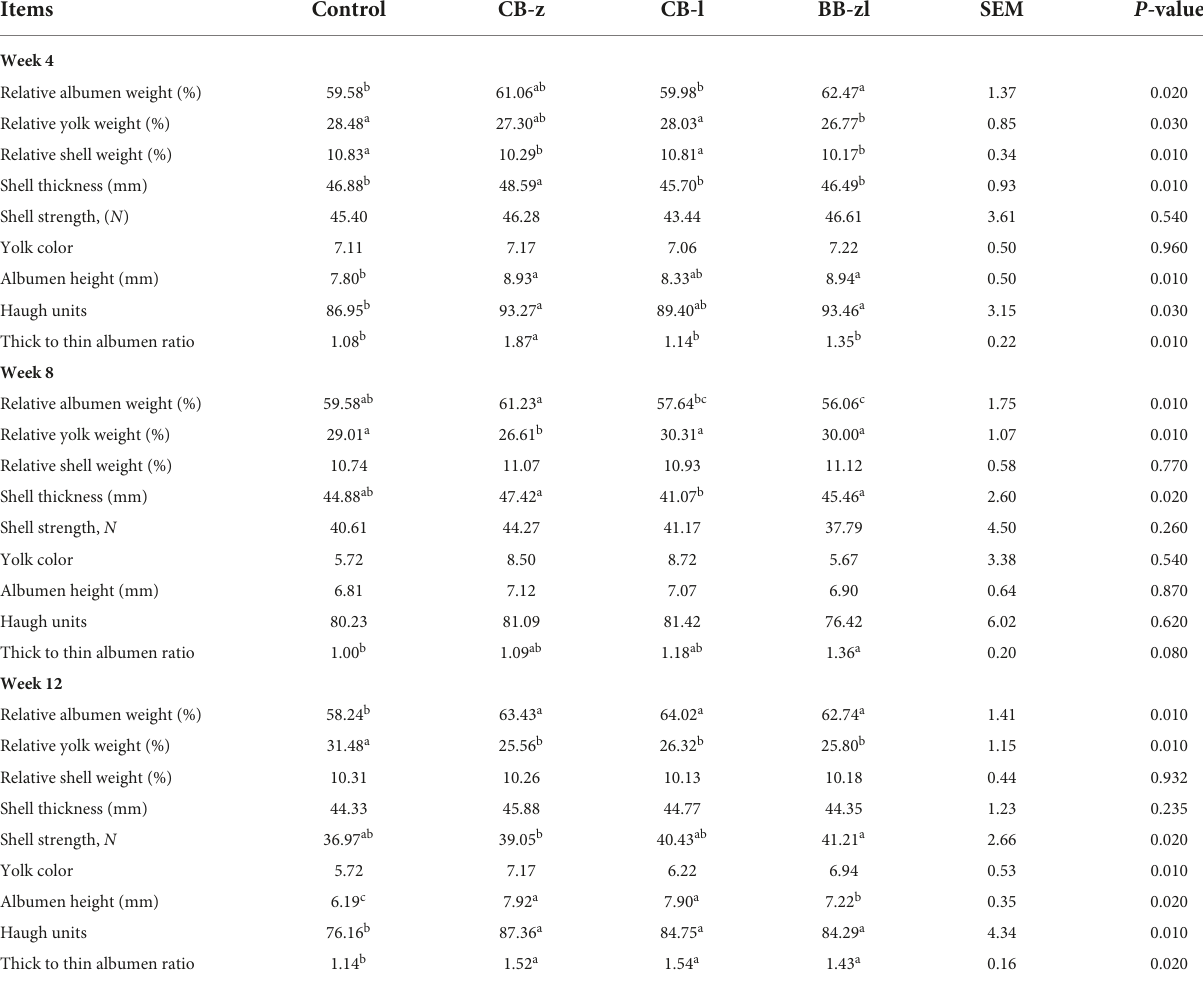
TABLE 3 Effects of Clostridium butyricum and Brevibacillus sp. on the egg quality of laying